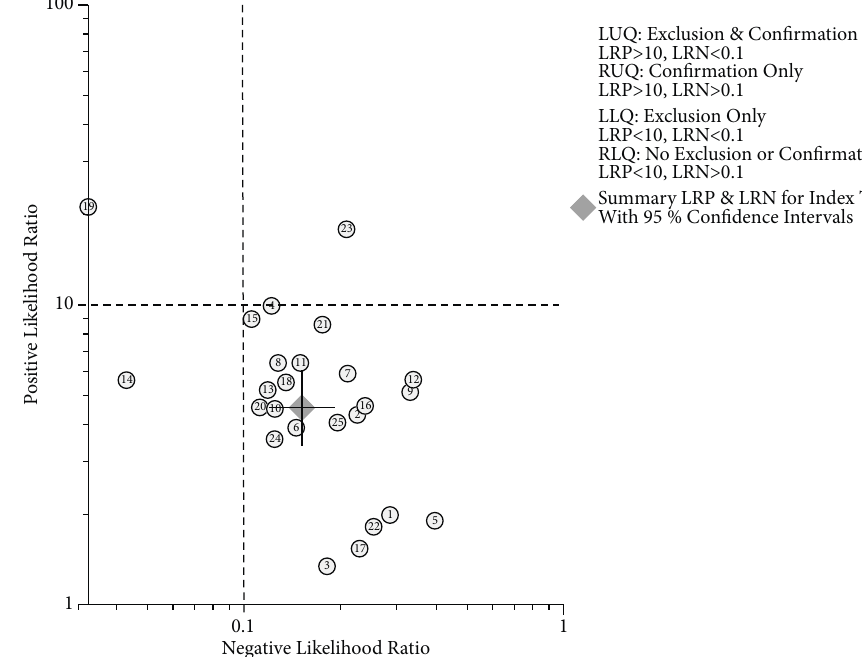
Figure 9: Evaluation of clinical applicability of AI-assisted diagnostic techniques in TN diagnosis: likelihood ratio scattergram. Funnel Plot Asymmetry Test pvalue = 0.18